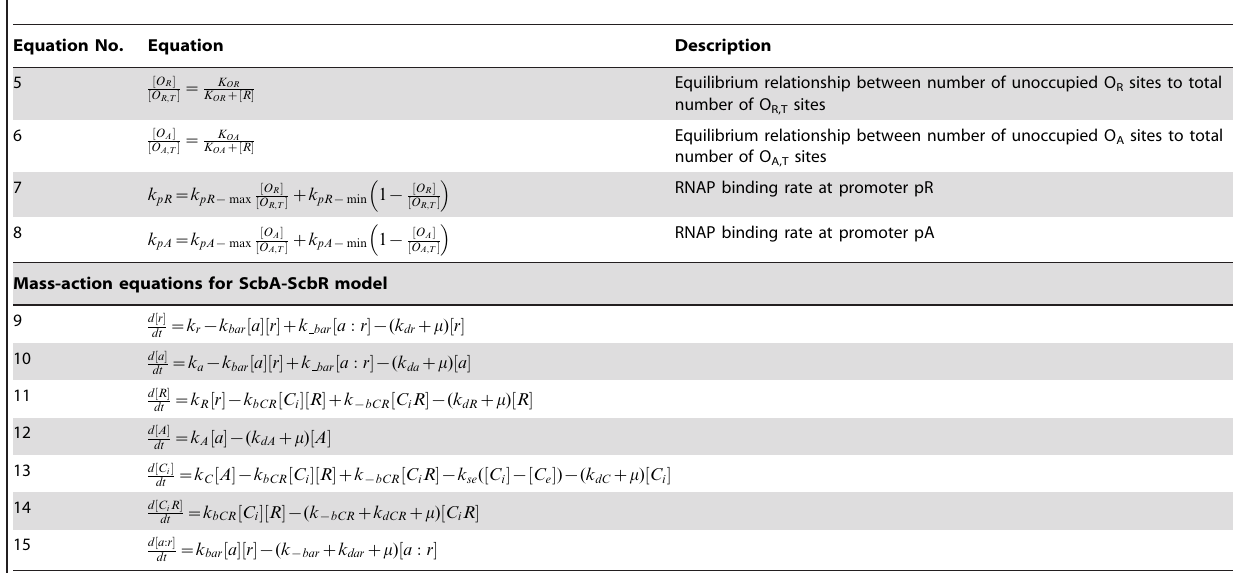
Table 2. Rates and Mass-action Equations for ScbA-ScbR model.